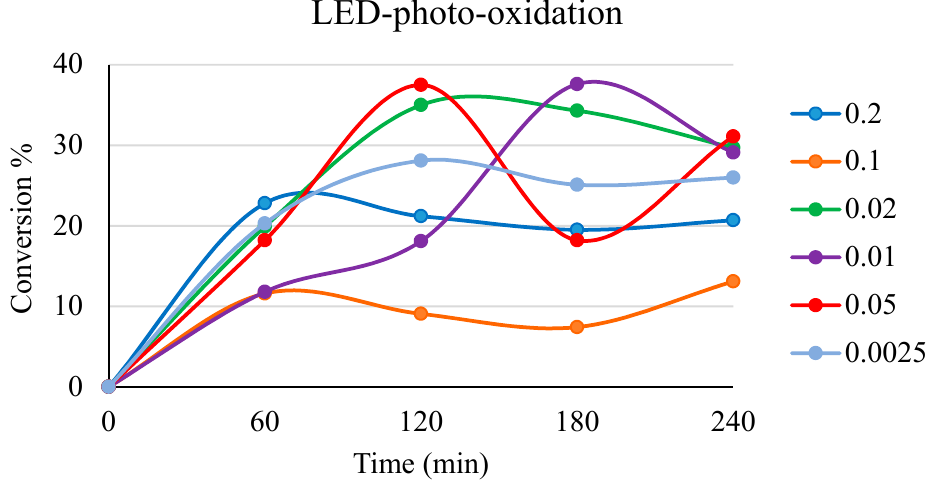
Figure 6. Photo-oxidation of NH 4+ at various concentrations of ammonium (0.0025–0.2 M) under LED lamp irradiation, using 0.1% Ag/FSP as a photocatalyst with fixed 0.2 mol NH 4+ /g cat, pH 5, r.t. and 250 mL of solution.